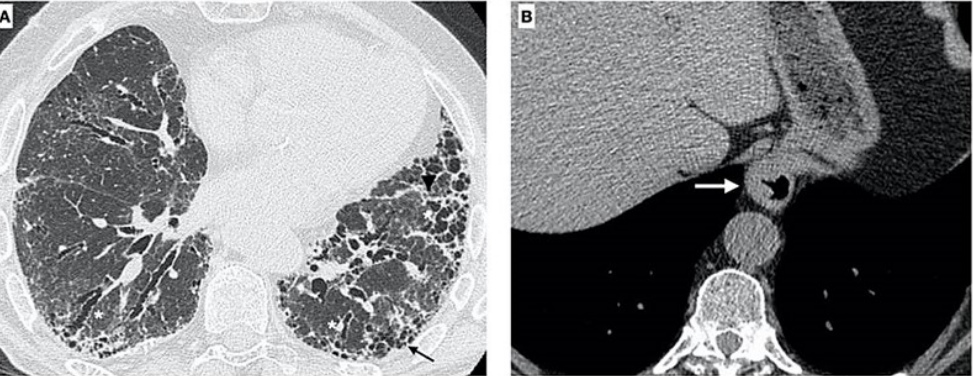
Figure 1. Axial chest CT images of a 73-year-old male with established IPF. ( A ) High-resolution image shows fibrotic changes due to the presence of diffuse irregular thickening of interlobular septa, traction bronchiectasis/bronchiolectasis, and honeycombing (black arrow); moreover, distortion of oblique fissure is visible. ( B ) CT also demonstrates the presence of a gastric (thoracic) hiatus hernia (white arrow).